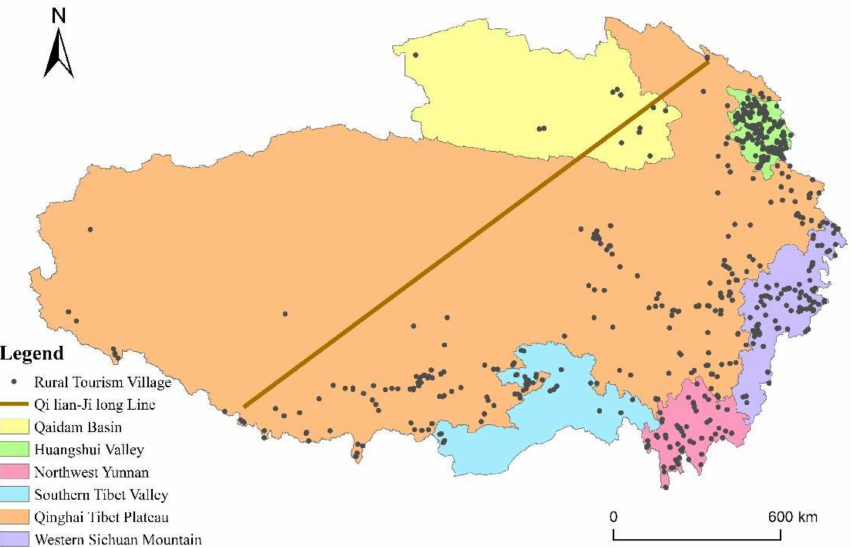
Figure 2. Spatial distribution of RT villages in QTP. The RT villages in QTP present uneven spatial distribution features between counties. Using geographic concentration index to measure the degree of equilibrium of RT villages, the result shows that the geographic concentration index is 13.3%. If RT villages were evenly distributed in each county, the geographic concentration index would be 6.1%. Therefore, the distribution of RT villages shows a weak degree of concentration at the county scale. The Lorenz curve was plotted using the cumulative percentage of RT villages to further reveal the unevenness of the distribution. As shown in Figure 3, the Lorenz curves presented a typical concave form, indicating that RT villages have an unbalanced distribution between counties. The largest number of RT villages are in Xunhua County, with 39 RT villages, and there are 38 counties with no RT